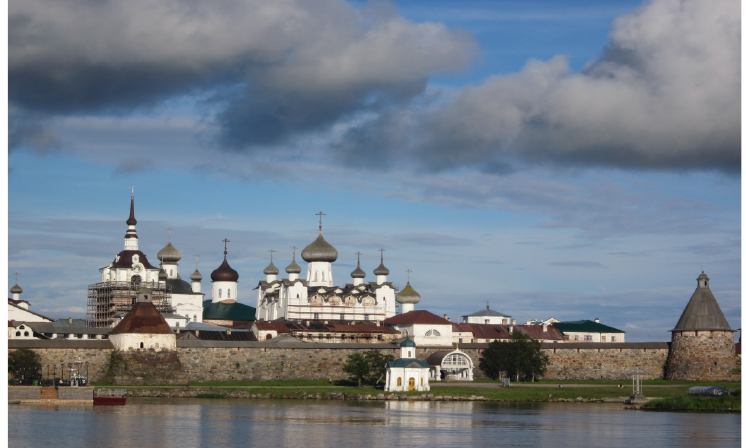
Figure 3. – Solovki. Blagopoluchiya Bay. The Orthodox Solovetsky Monastery of the Transfiguration of